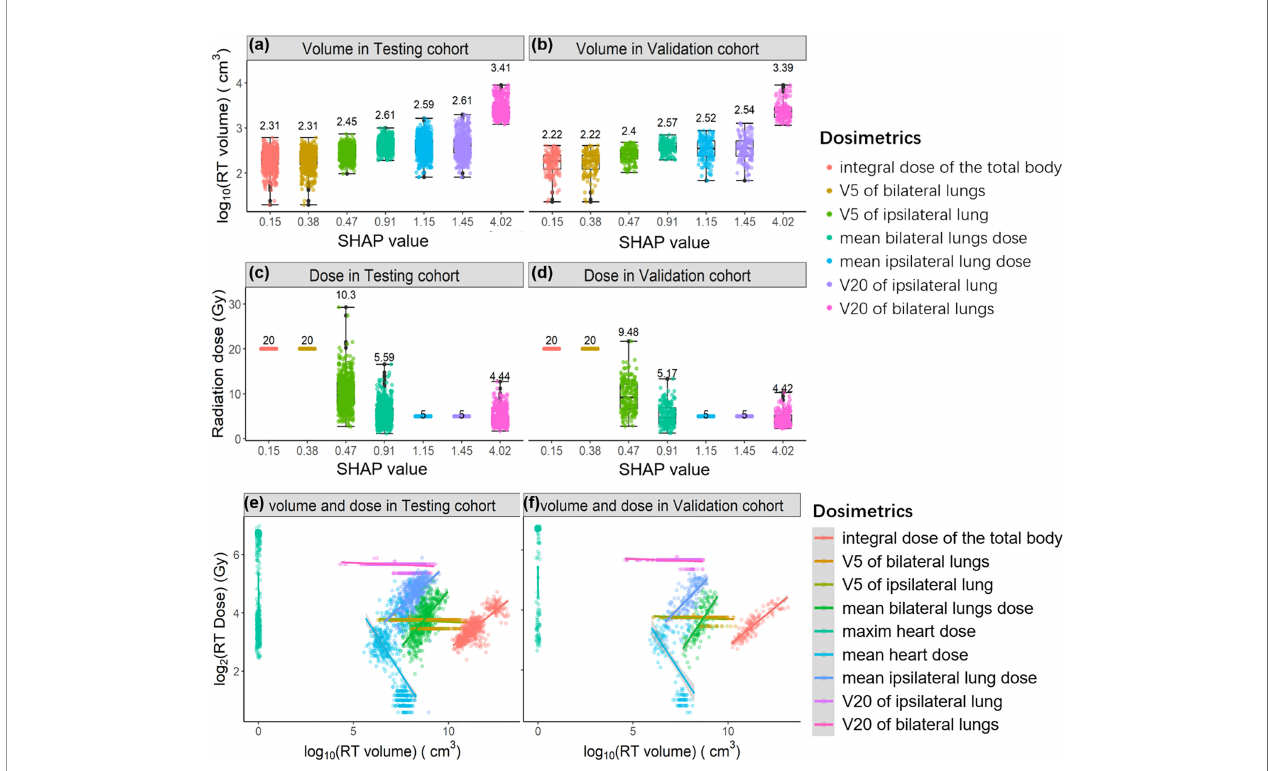
FIGURE 4 | The relationships between SHAP value and irradiation volume in the Testing cohort (A) and in the Validation cohort (B) ; the relationships between SHAP value and irradiation dose in the Testing cohort (C) and in the Validation cohort (D) . The regression relationships between irradiation volume and irradiation dose in the Testing cohort (E) and in the Validation cohort (F) . Each radiation dose is differently colored and sorted by SHAP